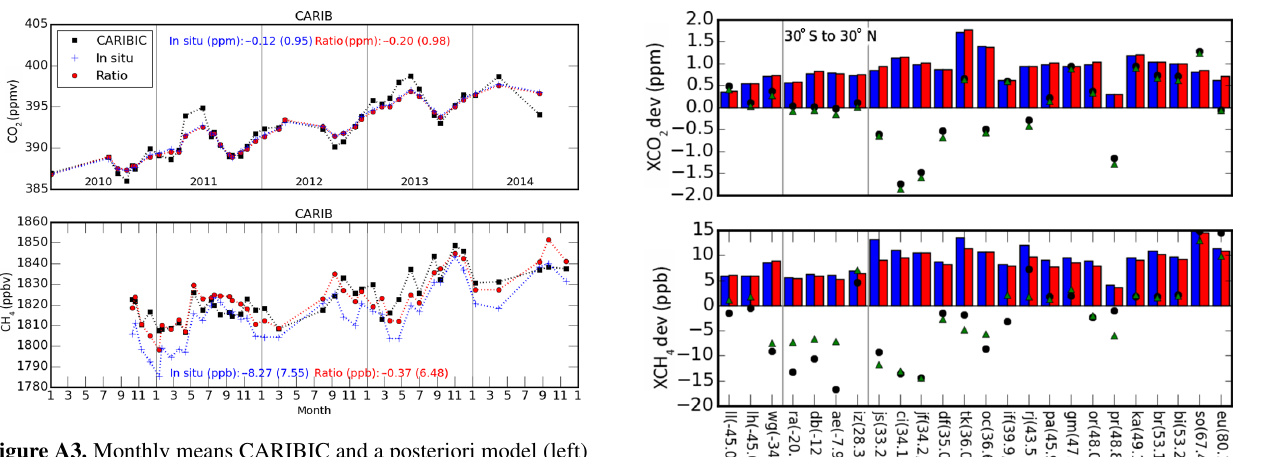
Figure A3. Monthly means CARIBIC and a posteriori model (left) CO 2 and (right) CH 4 mole fractions collected in the tropical mid- dle/upper troposphere (<300hPa) between 30 ◦ S and 30 ◦ N. The monthly mean biases (standard deviations) of the model minus data differences are shown in the inset. Figure A4. Mean multi-year statistics (2010–2014) of the differ-